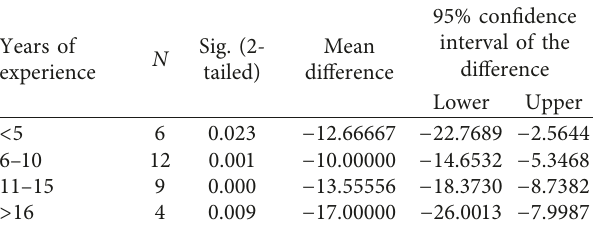
Table 5: Statistic and one-sample t -test for emotional exhaustion with reference to years of experience.